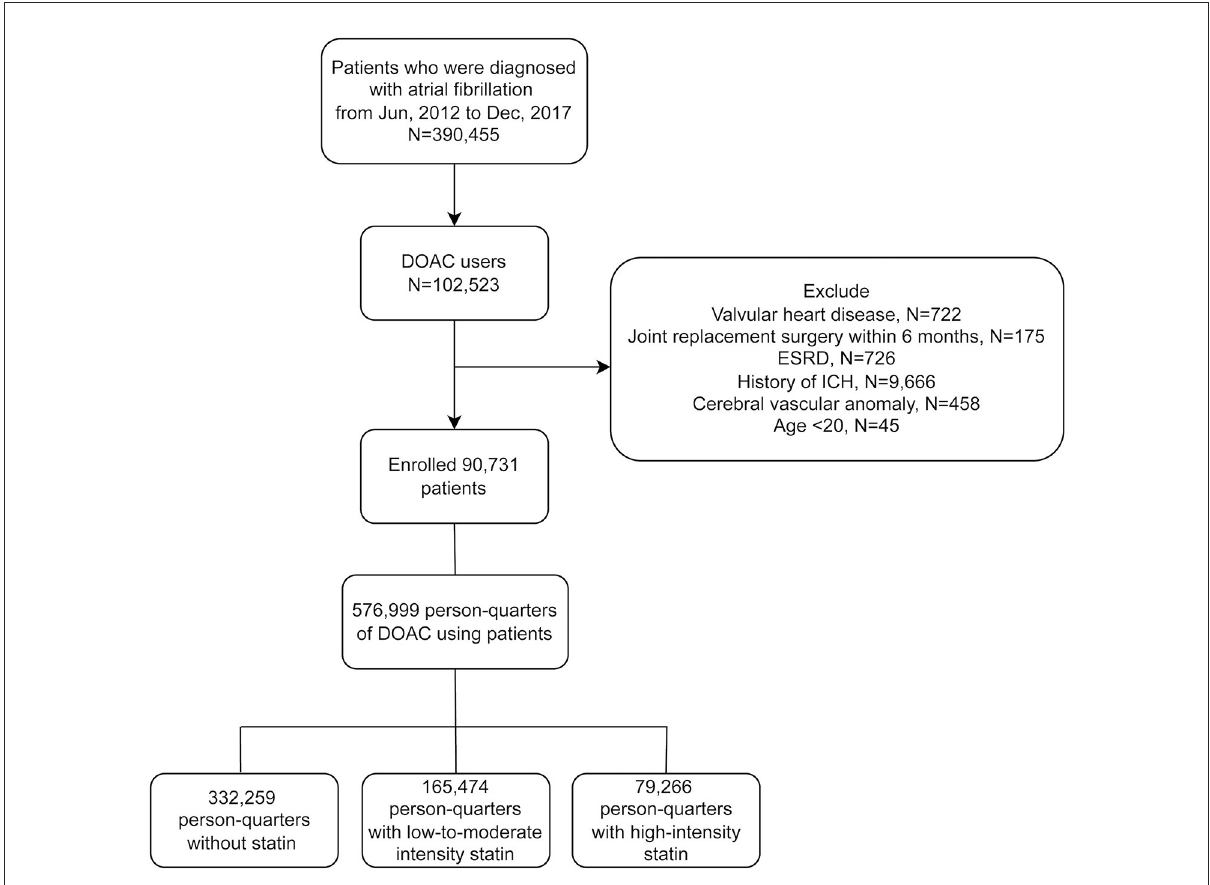
FIGURE1 Flowchart of the study protocol. DOAC, direct oral anticoagulant; ESRD, end-stage renal disease; ICH, intracerebral